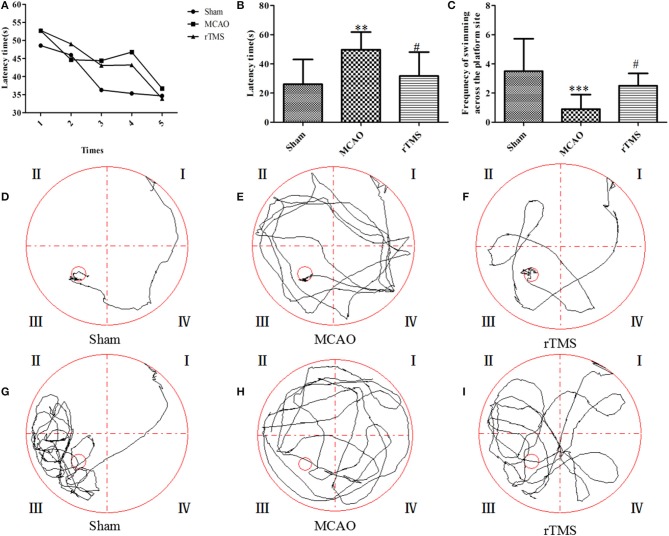
Effects of rTMS on cognitive impairment in the Morris water maze task. (A,B) Latencies to find the submerged platform from the 1st time to the 5th time. (C) The frequency of swimming across the platform site in the spatial probe trial. (D–F) Representative track plots of each group. (G–I) Representative track plots of the frequency of swimming across the platform in the spatial probe trials. The gray lines indicate the swimming traces. **P = 0.006 and ***P = 0.002 for the MCAO group vs. the Sham group; #P < 0.05 for the rTMS group vs. the MCAO group.